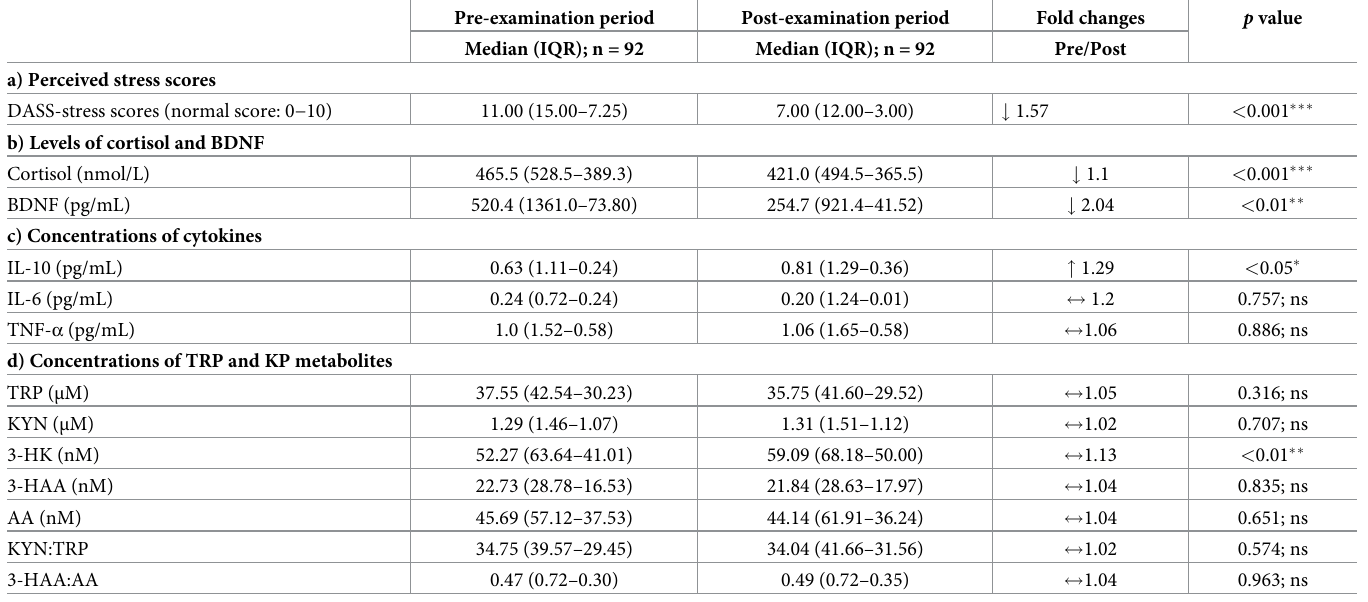
Table 1. Changes in a) perceived stress scores, b) the levels of cortisol and BDNF, c) concentrations of cytokines, and d) concentrations of TRP and KP metabolites dur- ing pre-examination and post-examination